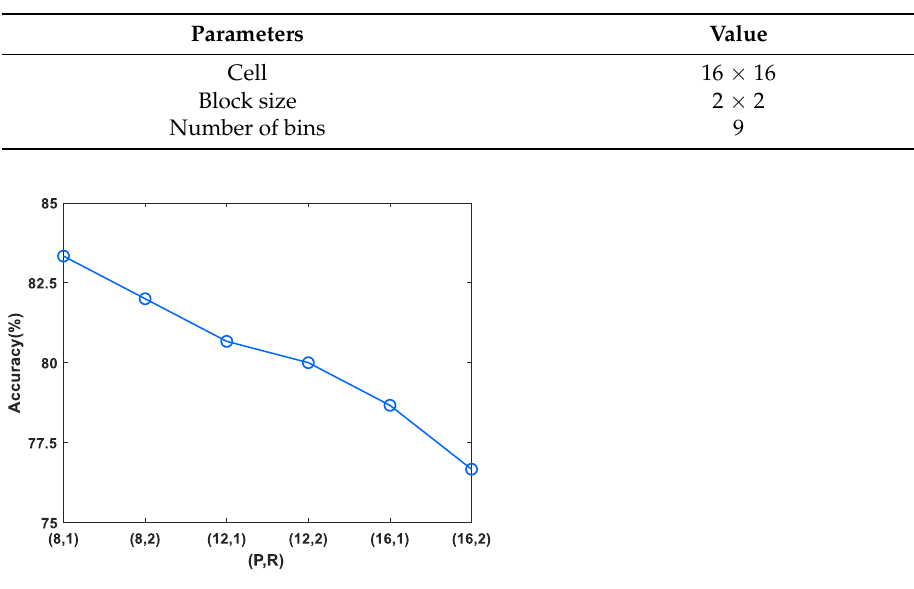
Figure 8. Performance of LBP with different (P, R).